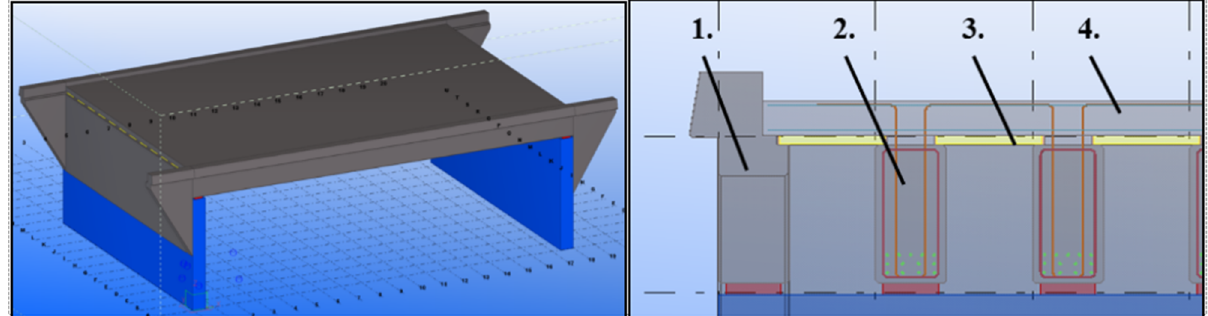
Figure 3. ( Left ) BIM of the bridge; ( Right ) superstructure components 1 = Edge beam, 2 = Beam, 3 = Plate, 4 =